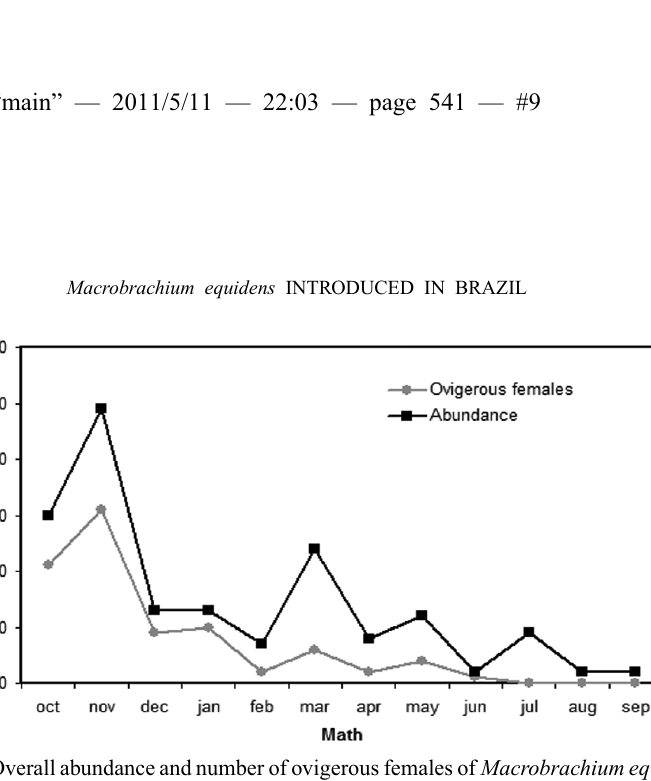
Fig. 6 – Overall abundance and number of ovigerous females of Macrobrachium equidens collected each month in the Caeté Estuary between October 2001 and September